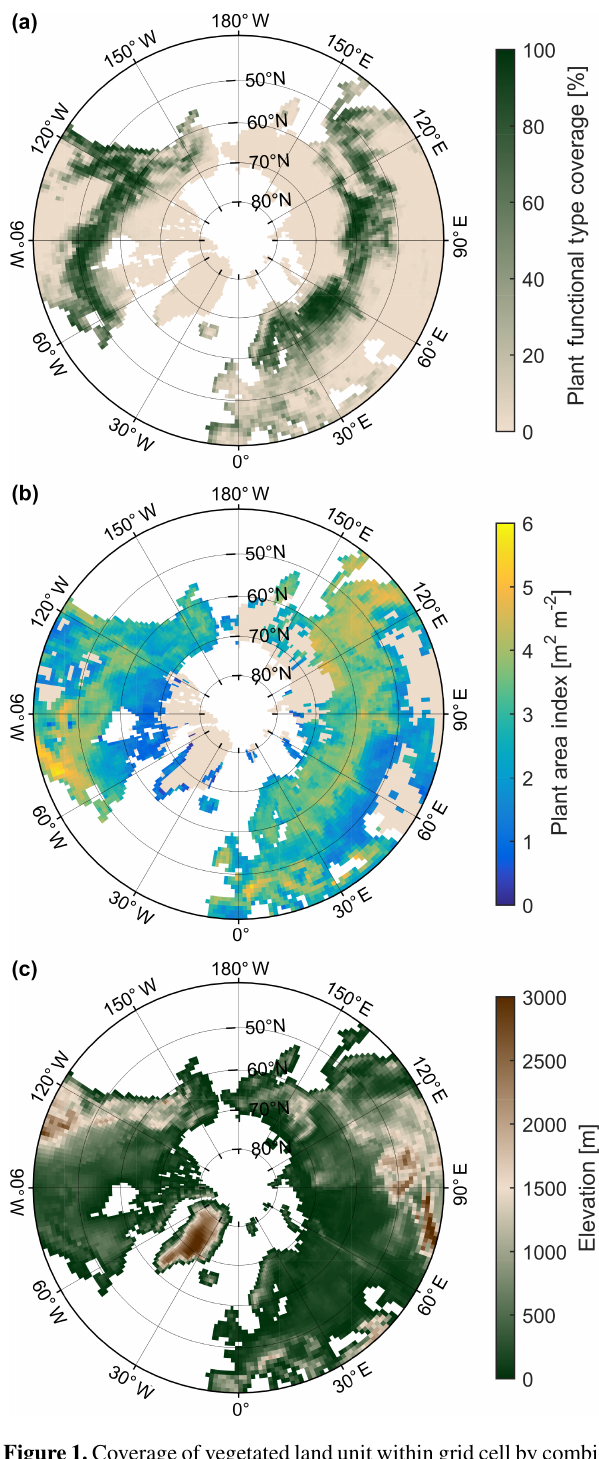
Figure 1. Coverage of vegetated land unit within grid cell by combi- nation of needleleaf evergreen boreal trees (NEBTs) and needleleaf evergreen temperate trees (NETTs) (a) , plant area index (PAI) for combination of NEBTs and NETTs weighted by PFT fractions (b) , and grid-cell average elevation (c) based on CLM4.5’s 0 . 9 ◦ × 1 . 25 ◦ surface